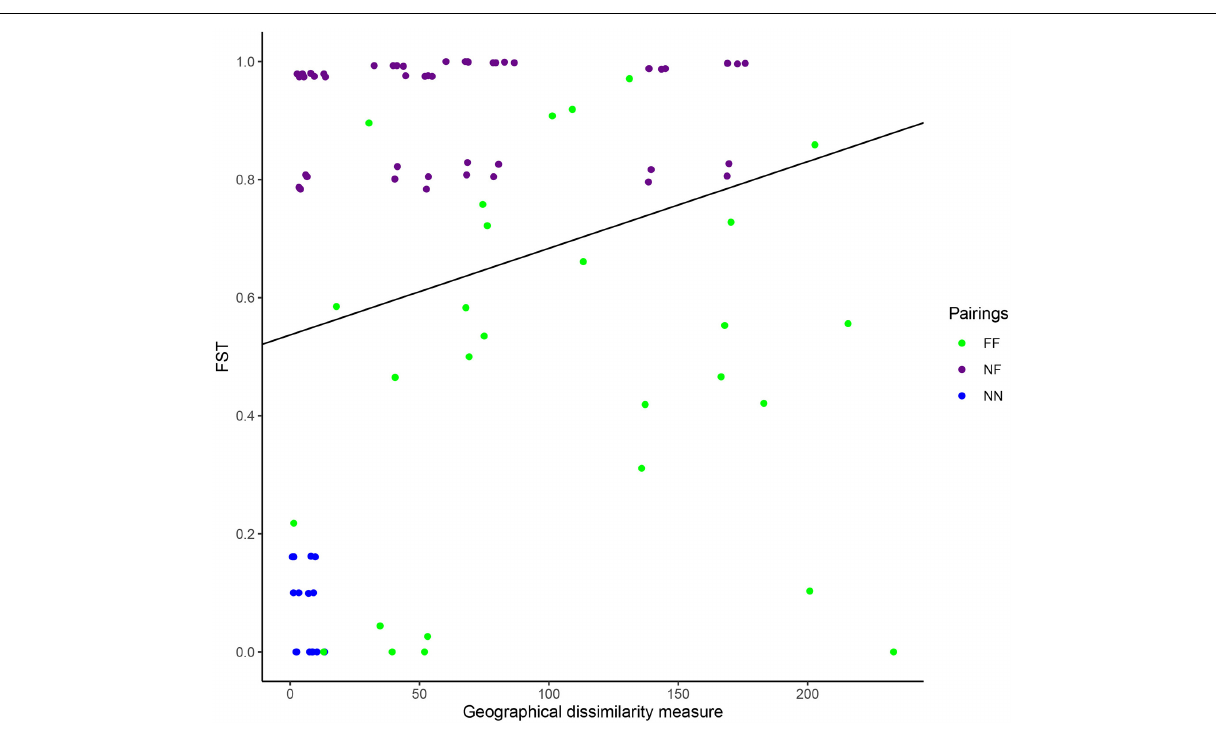
Frontiers in Ecology and Evolution |